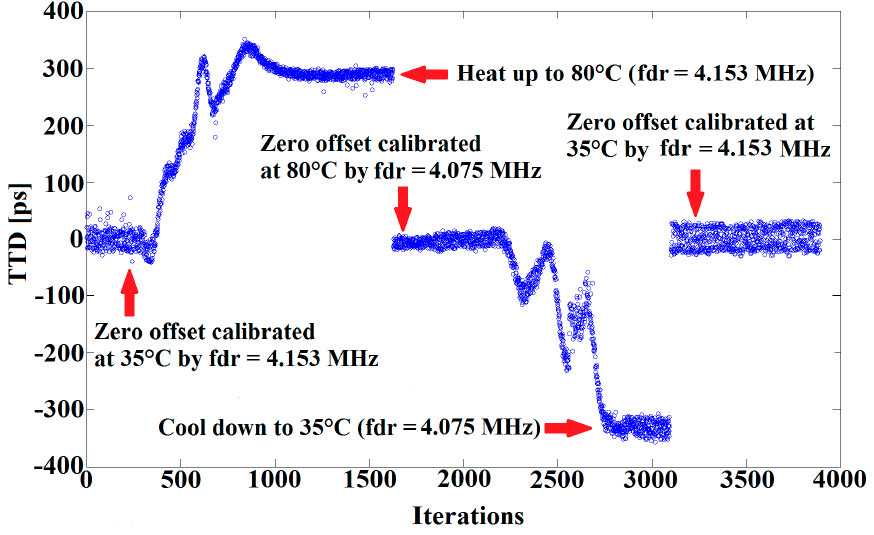
Figure 14. TTD measurements performed over a temperature range from 35 °C to 80 °C.